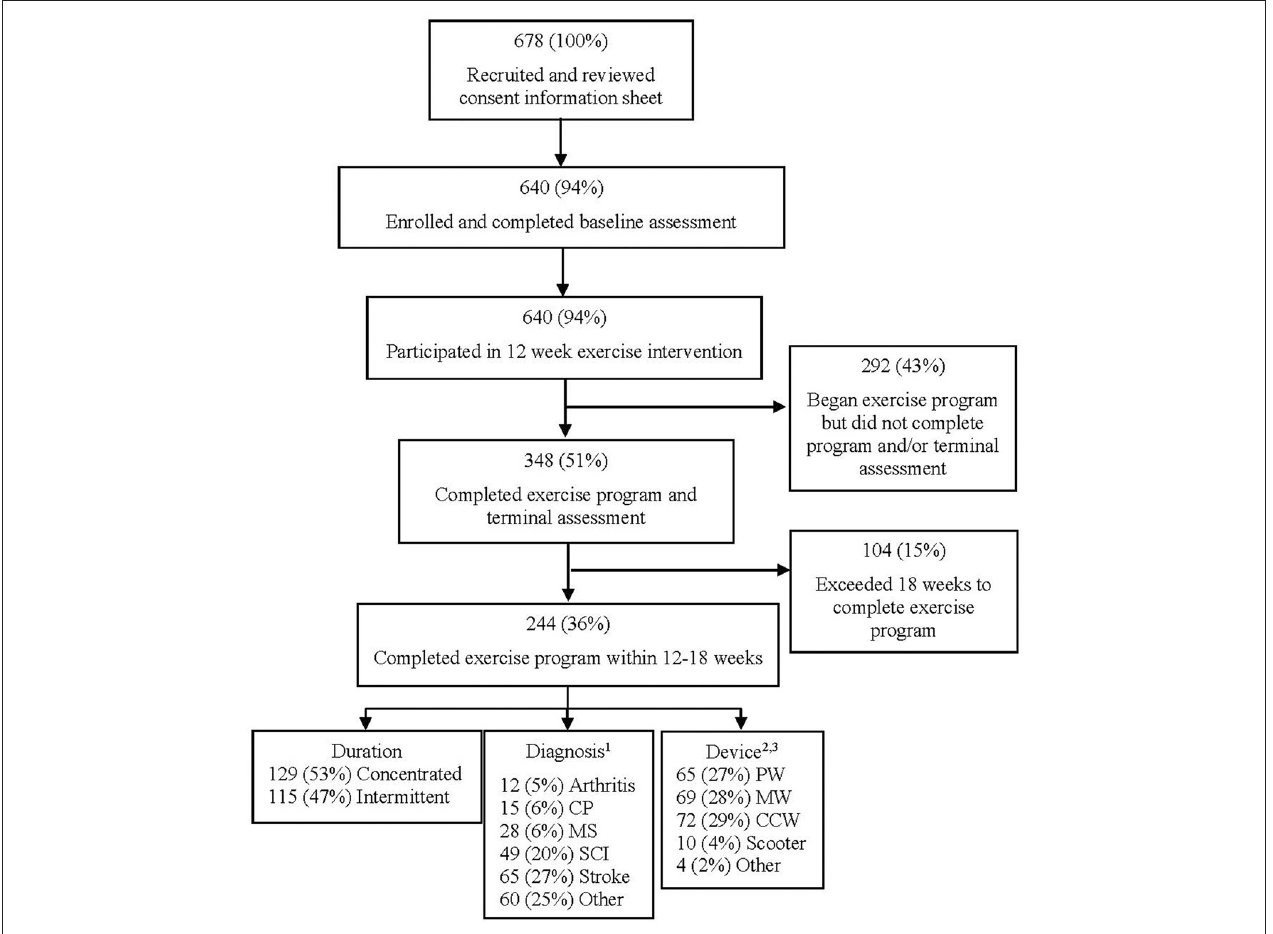
FIGURE 1 | Participant recruitment, enrollment, and study participation flow diagram. 1 Refused to answer the diagnosis survey question ( n = 15, 11%). 2 PW—power wheelchair, MW—manual wheelchair, CCW—cane, crutches, and walkers. 3 Refused to answer the device-used survey question ( n = 24,